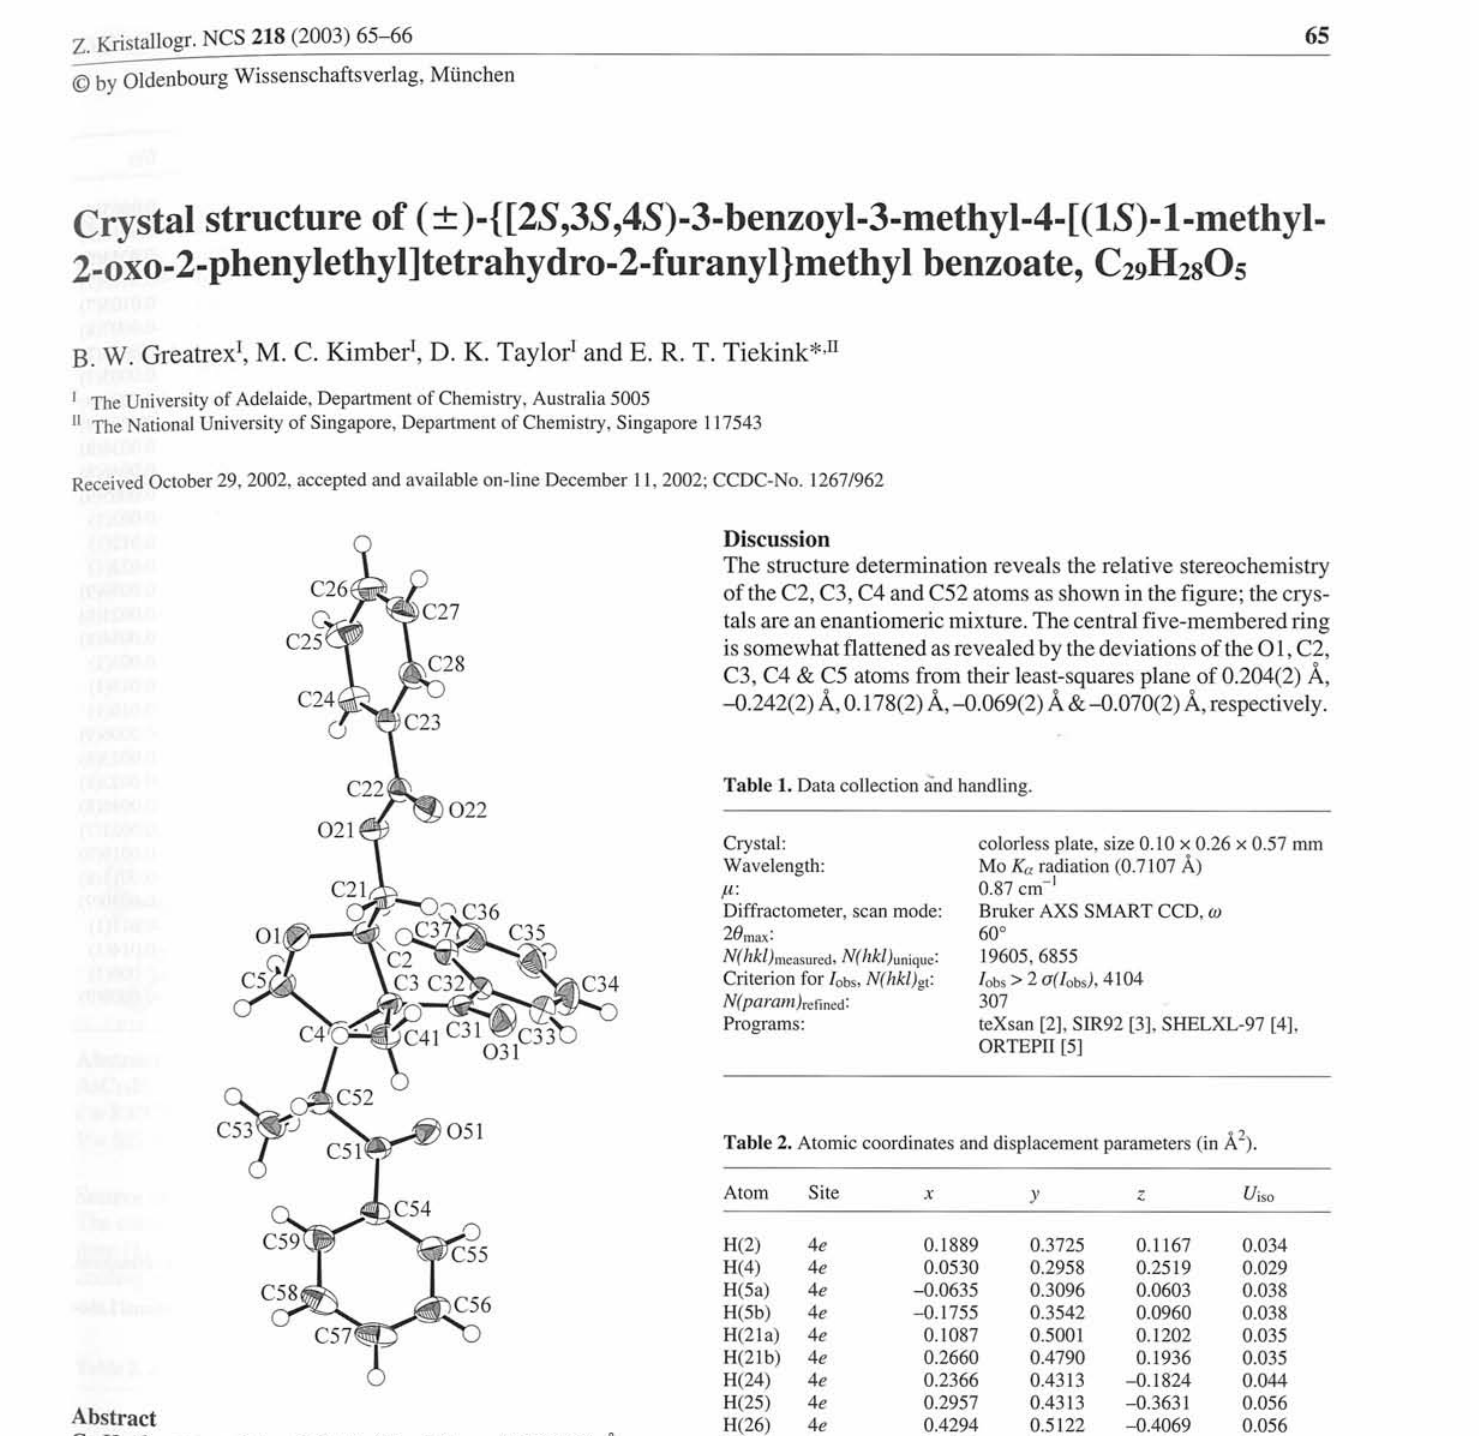
Table 2. Atomic coordinates and displacement parameters (in